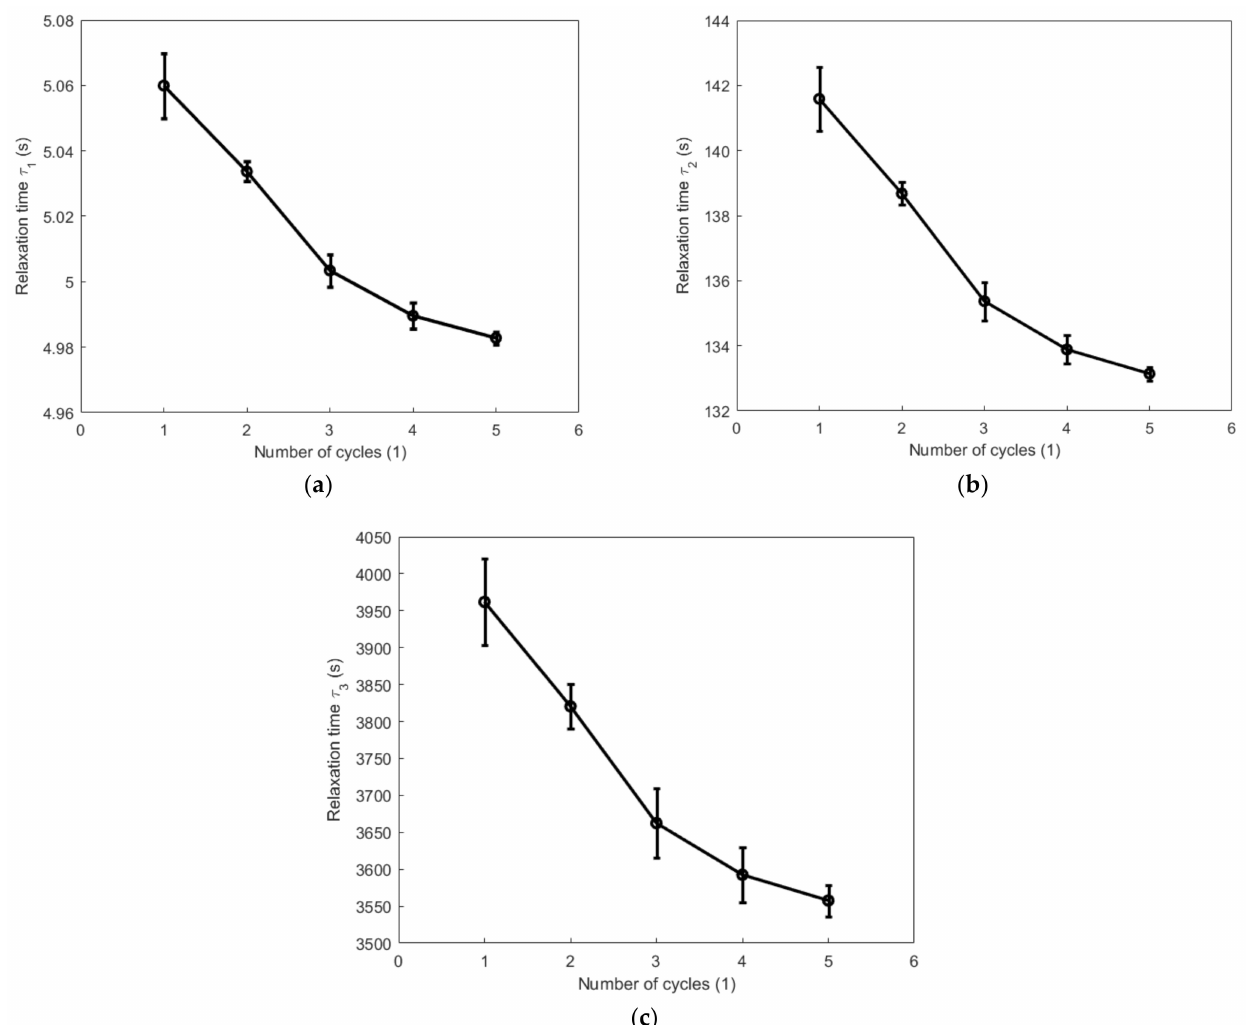
Figure 17. Evolutions of relaxation times τ 1 , τ 2 , and τ 3 with respect to the number of cycles during